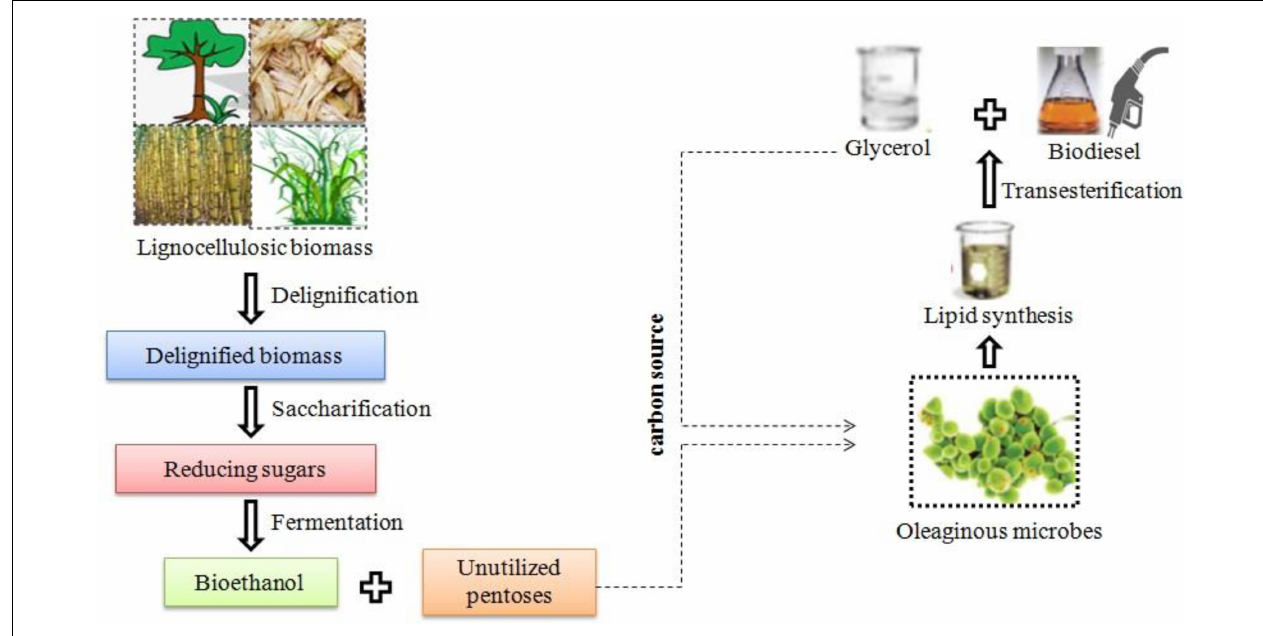
FIGURE 2 | Schematic diagram of integrated biofuel production from lignocellulosic biomass using oleaginous microorganisms.